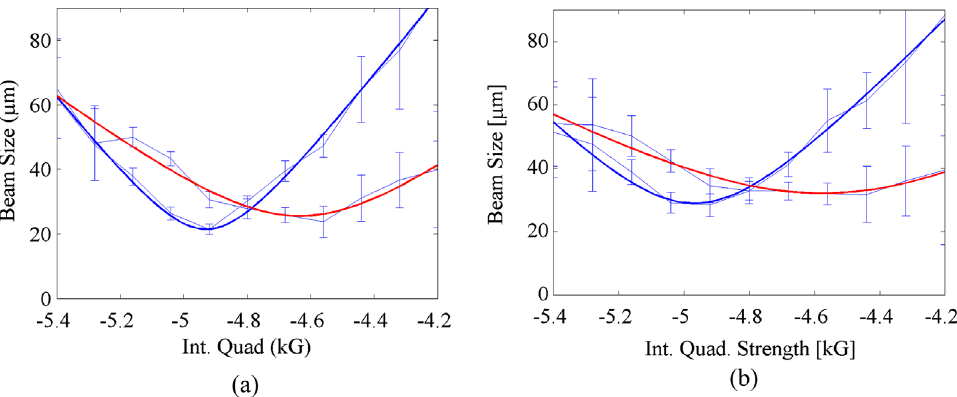
FIG. 25. Beam size versus quadrupole strength: (a) rms beam size obtained from Gaussian fits, (b) rms beam size obtained using a 5% area cut. The blue (red) curves are fits to the horizontal (vertical) data. The rms emittances are 0.32 mm-mrad and 0.28 mm-mrad, respectively, in the horizontal and vertical plane for the rms fits. They are 0.36 mm-mrad and 0.28 mm-mrad, respectively, in the horizontal and vertical plane for the Gaussian